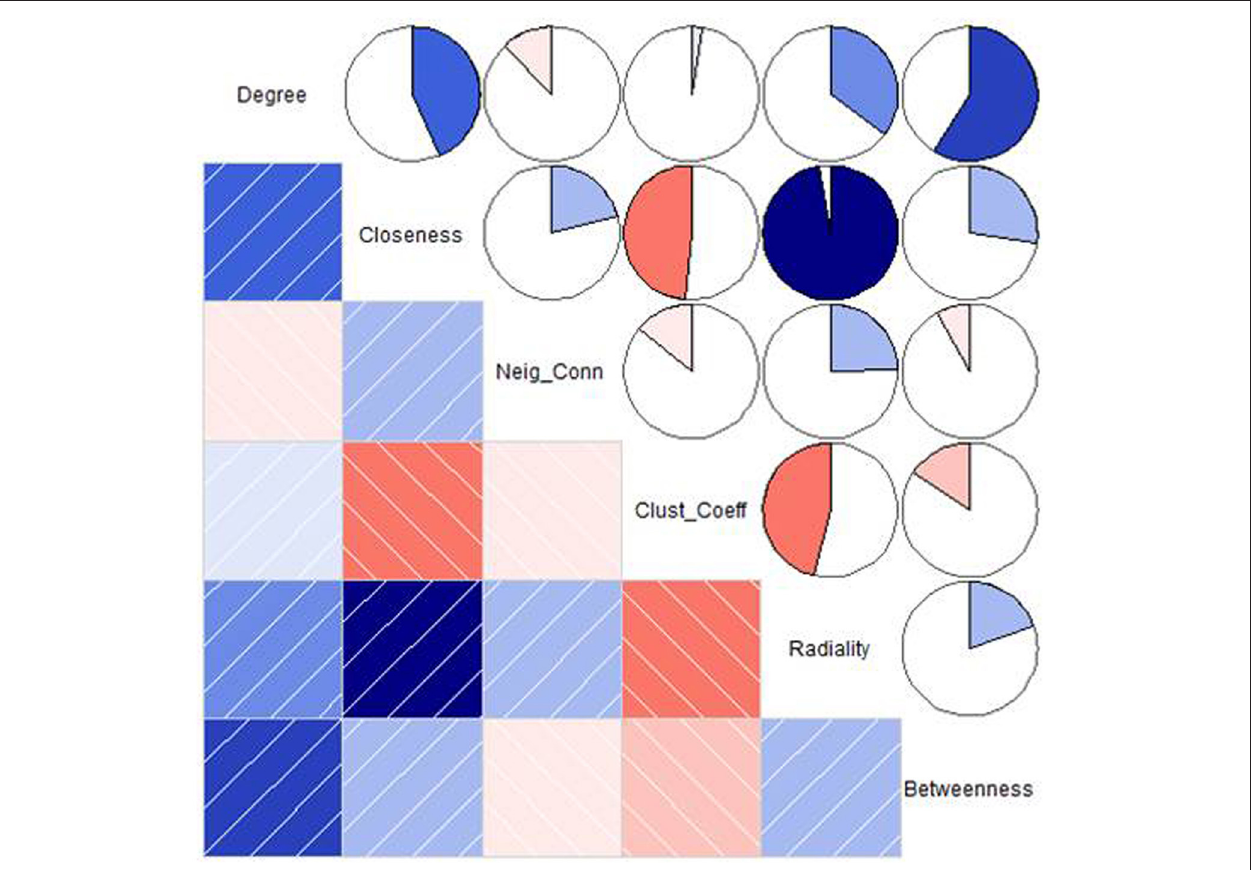
FIGURE 5 | A correlogram depicting the Pearson’s correlation coefficients between the network parameters. In the lower triangle the correlations are represented as a color-coded shaded chart indicating positive and negative correlations. The upper triangle depicts pie chart. Shades of blue indicating positive correlations (the darker shade the stronger is the positive correlation) and shades of red indicating negative correlations (the darker shade the stronger is the negative